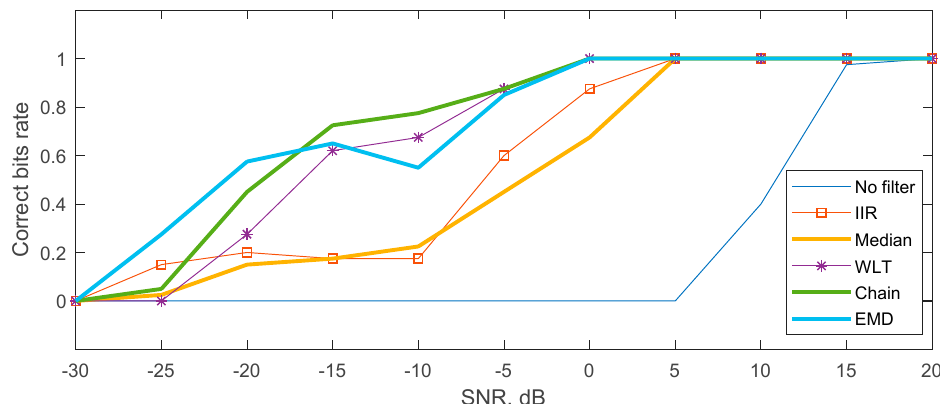
Figure 11. Ratio of correctly recognized bits according to SNR level in communication channel and filtration method: IIR —4-th order low-pass Butterworth filter; MED – median filter; WLT —wavelet transform filter using external phase Daubechies wavelet with 8 vanishing moments; EMD — conventional EMD filter; Chain — chain of driven oscillators technique.